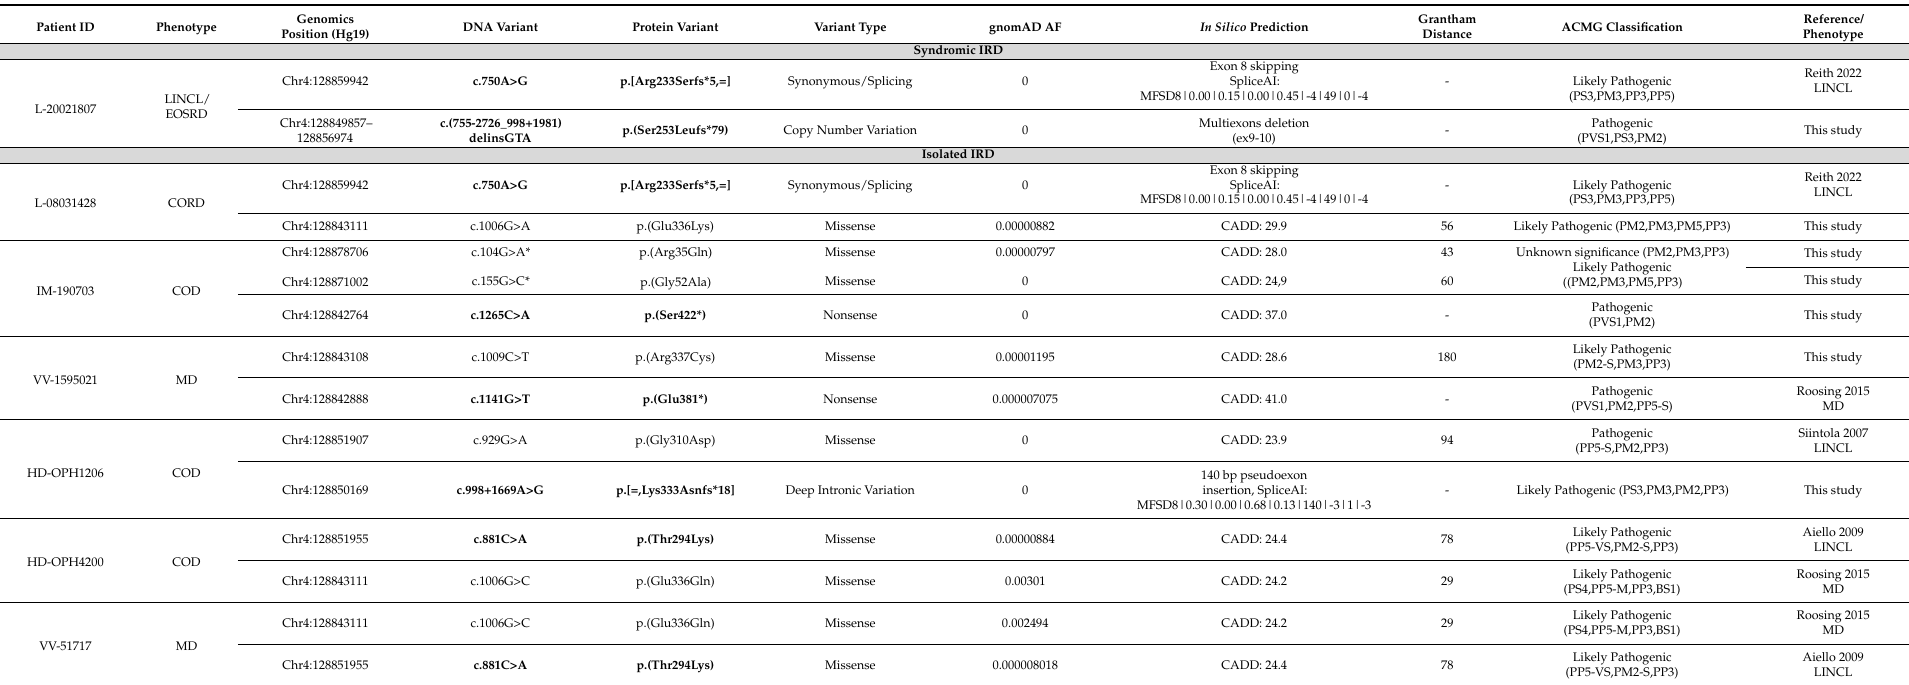
Table 2. MFSD8 (NM_152778.3) genotypes identified in our